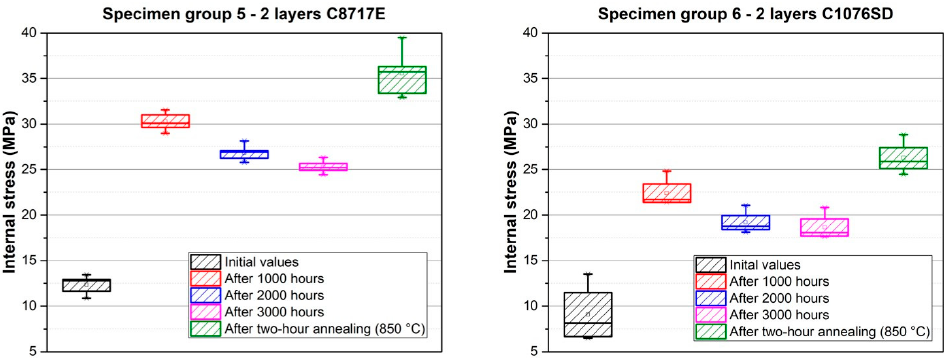
Figure 12. Internal stress changes over time for silver films—specimen group 5 ( left ), and specimen group 6 ( right ).